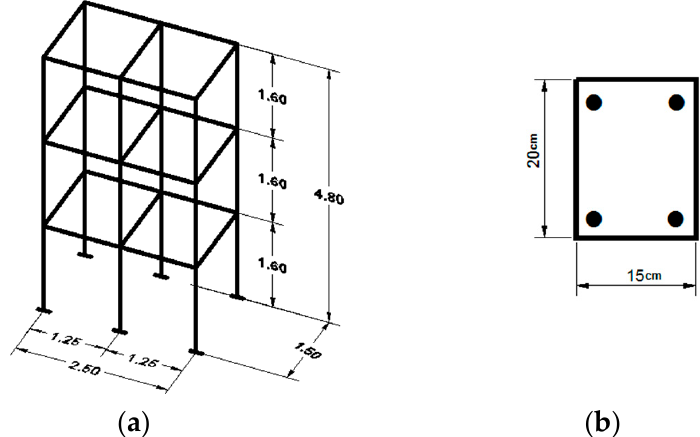
Figure 2. The dimensions and sections of the RC building model. ( a ) 3D-view of three storeys; ( b ) the beam and column sections.